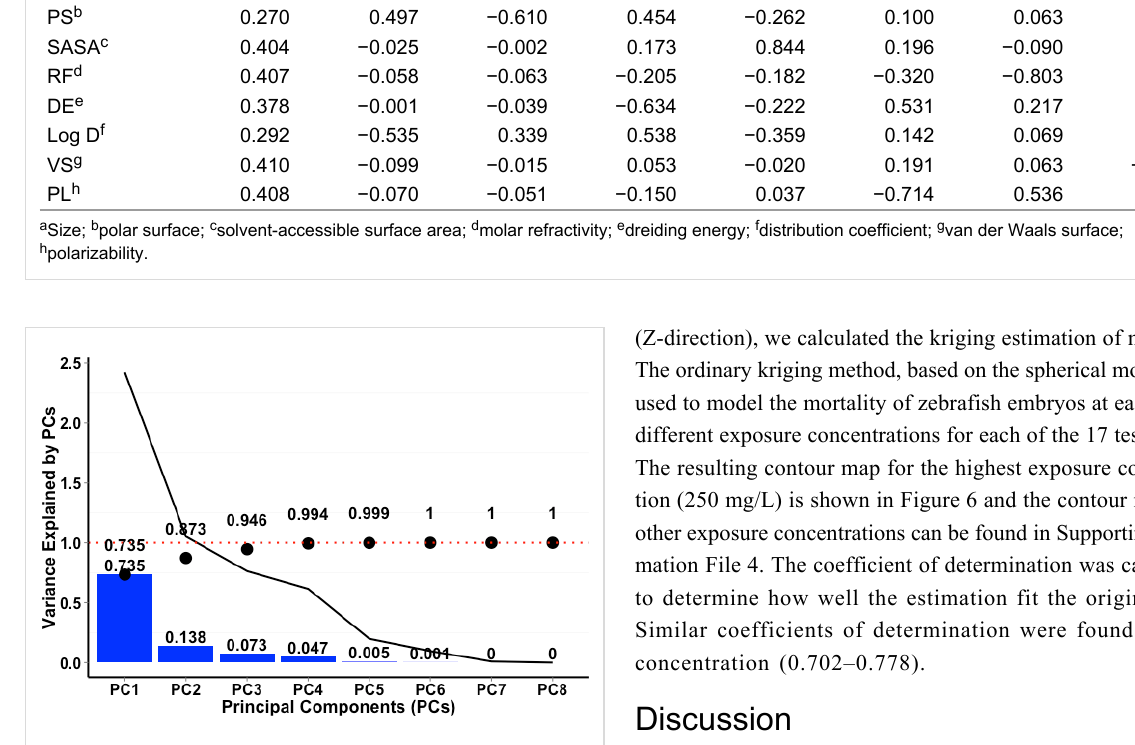
Figure 4: Individual variance for each of the principal components (PCs). Black dots represent the accumulated variance explained by each PC, while the solid line shows the